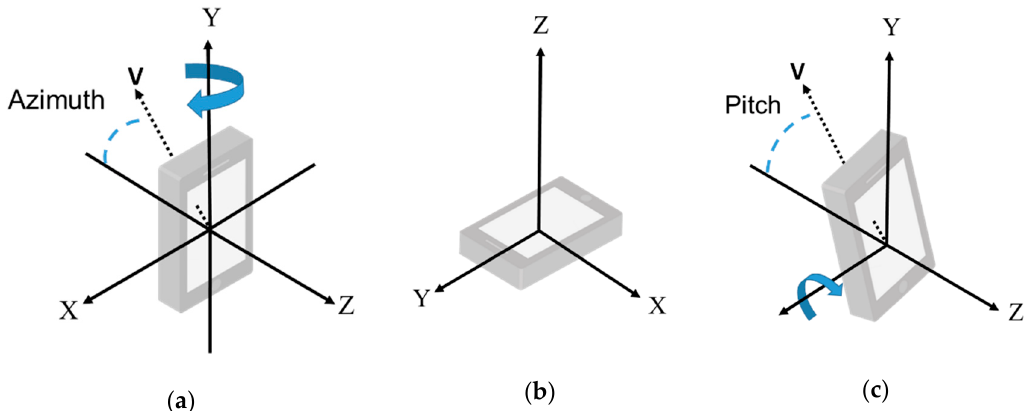
Figure 8. The orientation of a smartphone. ( a ) Phone is keeping upright; ( b ) Phone is lying flat; ( c ) The definition of pitch.